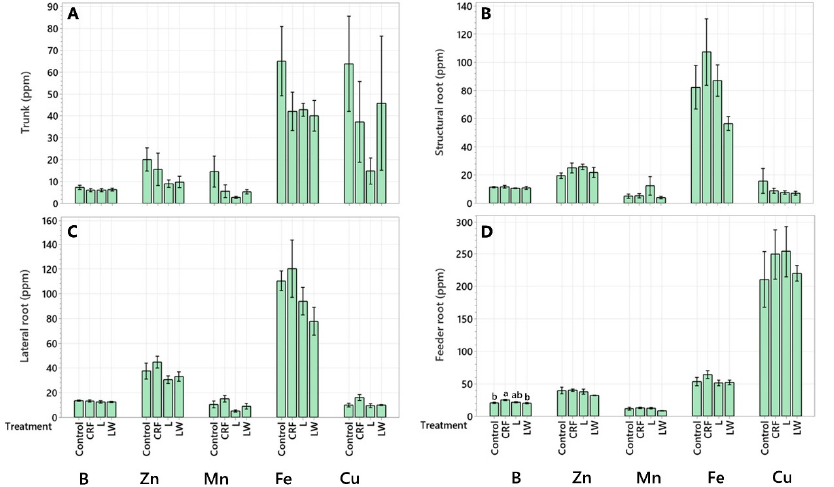
Figure 4. Micronutrient concentration (ppm) in trunk ( A ), structural root ( B ), lateral root ( C ), and